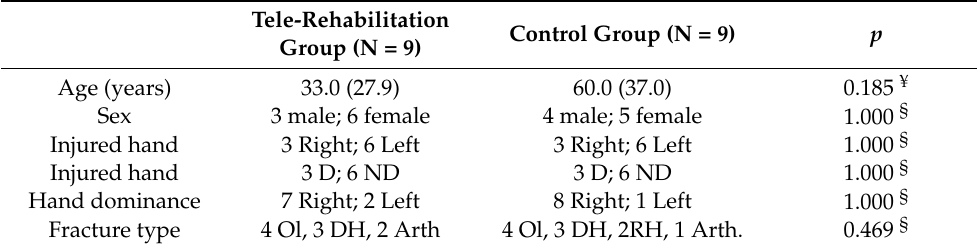
Table 1. Personal characteristics of the participants in the tele-rehabilitation and control groups. Values are presented as median and interquartile range in